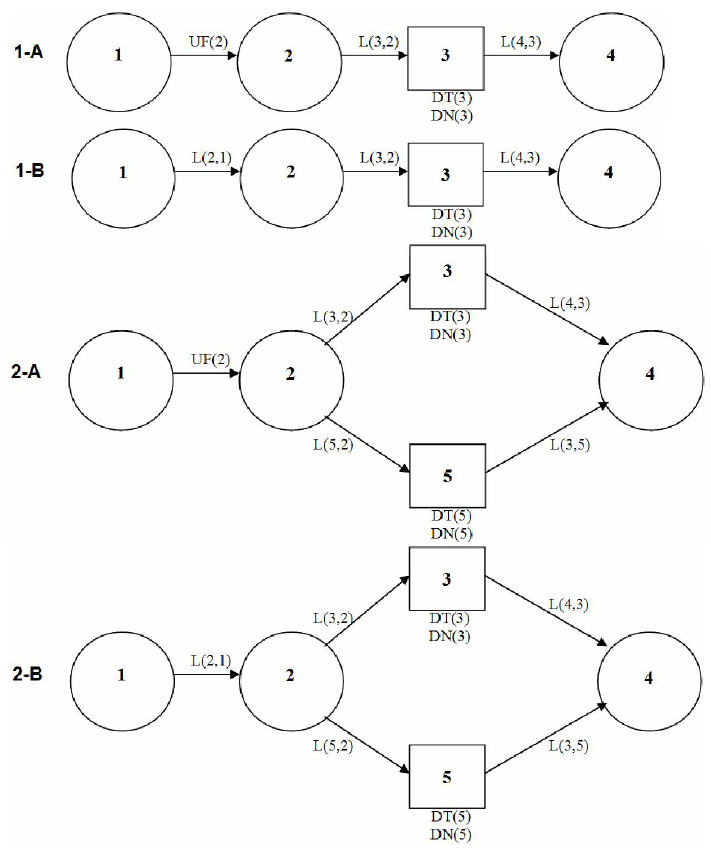
Figure 1. Schematic Compartmental models for transdermal transport of losartan using WinSAAM